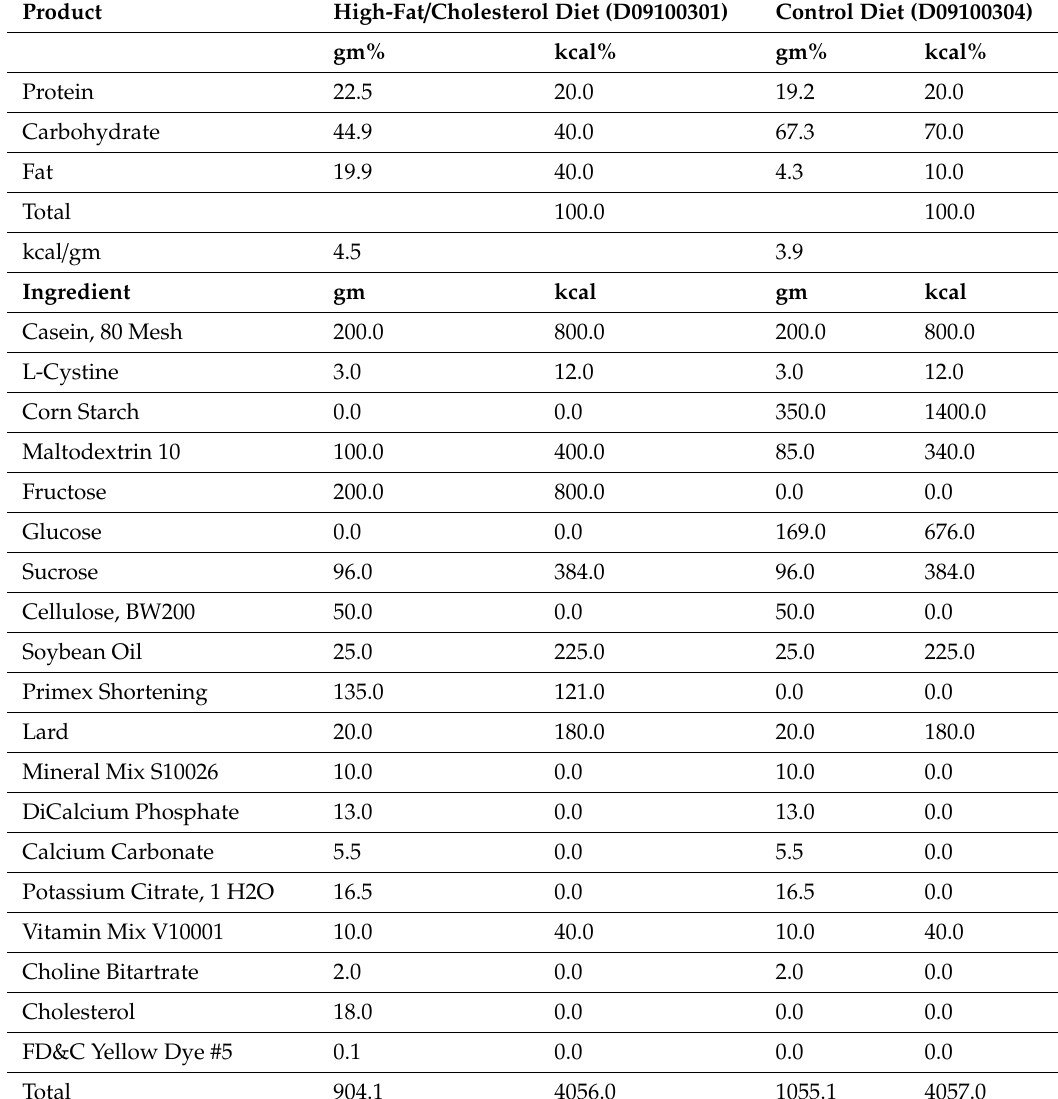
Table 2. Composition of control diet (D09100304) and high-fat and high-cholesterol diet